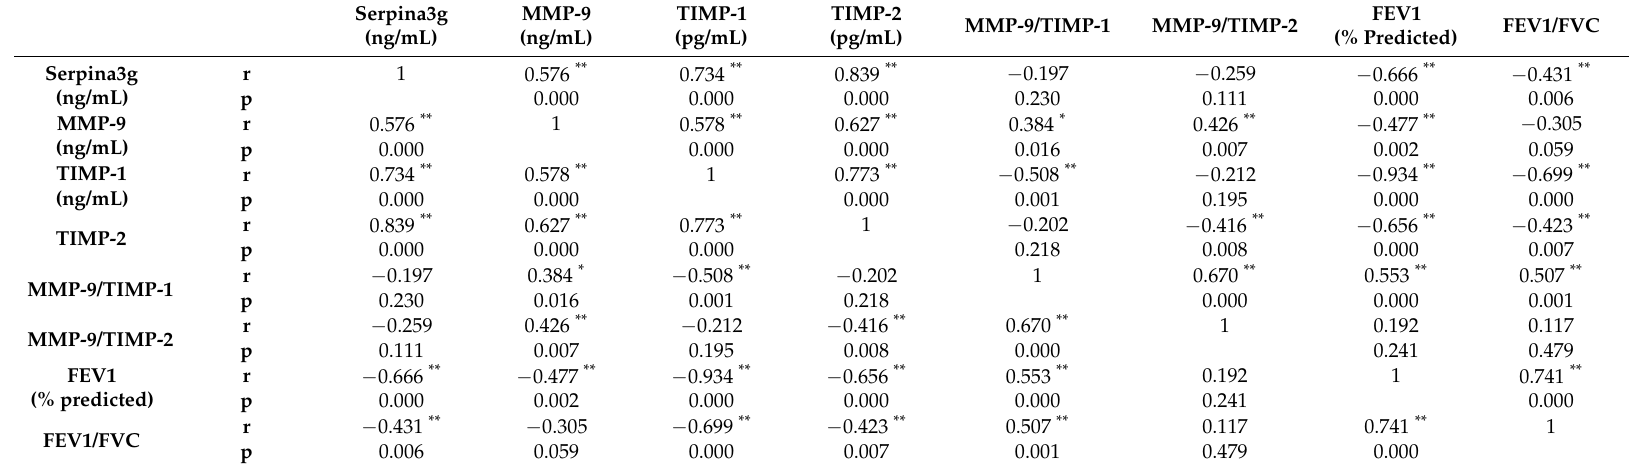
Table 2. Correlation analysis between protease–antiprotease levels and FEV1 and FEV1/FVC in group